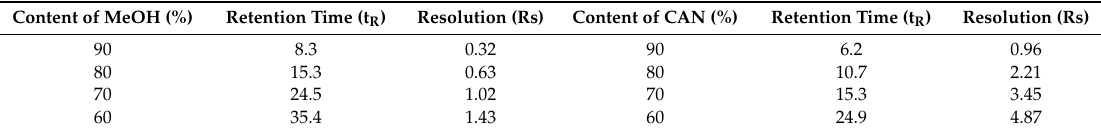
Table 1. The e ff ect of mobile phase compositions on resolution (Rs) and retention time (t R